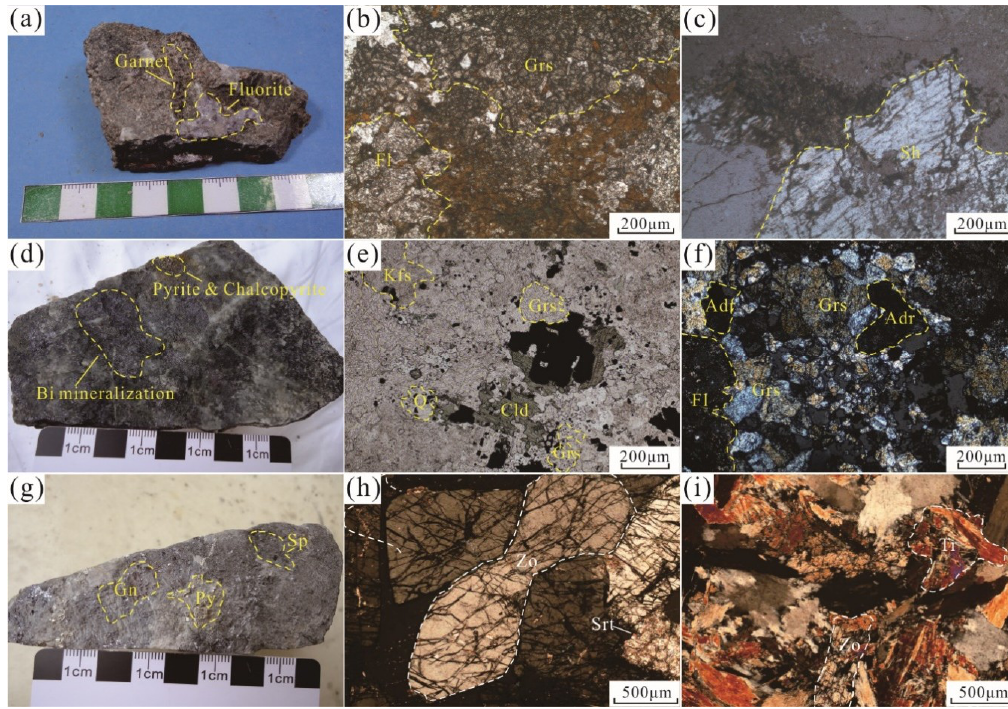
Figure 5. Photos of hand specimen and thin sections of skarn samples. The Huangshaping deposit: ( a ) garnet-fluorite skarn, ( b ) grossularite and fluorite in garnet skarn, ( c ) scheelite mineralization in garnet skarn; The Shizhuyuan deposit: ( d ) Bi-mineralized skarn, ( e ) grossularite, chloritoid, quartz and feldspar in ore-bearing garnet skarn, ( f ) grossularite, andradite and fluorite in ore-bearing garnet skarn; The Xianghualing deposit: ( g ) Sn-mineralized skarn ore, ( h ) zoisite and sericite in skarn, ( i ) zoisite and tremolite in skarn. Adr: andradite; Cld: Chloritoid; Fl: fluorite; Gn: galena; Grs: grossularite; Kfs: K-feldspar; Sh: scheelite; Sp: sphalerite; Srt: sericite; Py: pyrite; Q: quartz; Tr: tremolite; Zo: zoisite.